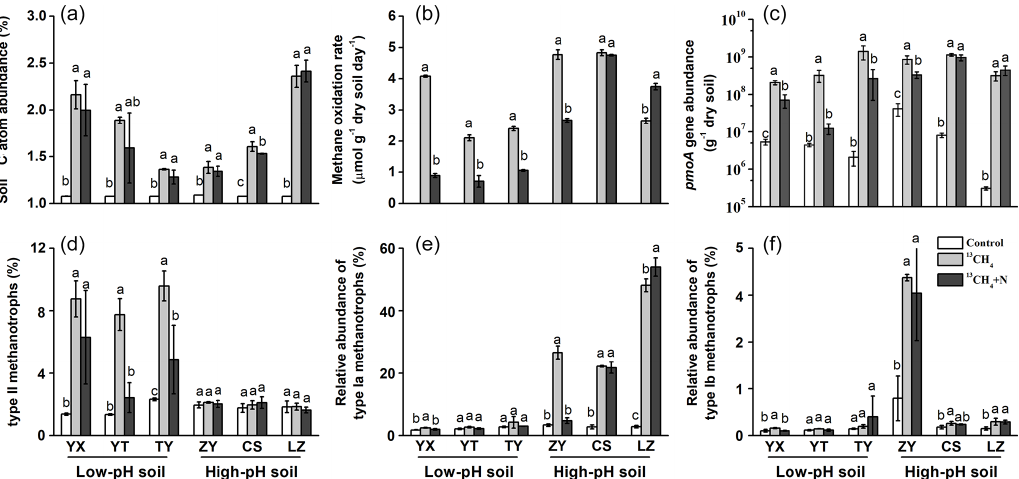
Figure 1. Changes in soil 13 C-atom abundances, methane oxidation rates, abundances and compositions of methanotrophs following soil microcosm incubation. (a) Soil 13 C-atom abundance was measured to assess methane assimilation in soil microcosms amended with 5% 13 CH 4 . (b) The soil methane oxidation rate was compared between soil microcosms incubated with or without NH 4 NO 3 fertilization. (c) The pmoA gene copy numbers of methanotrophs were estimated using real-time qPCR. Illumina sequencing targeting 16S rRNA genes was performed at the whole microbial community level, and the relative abundance of type II (d) , type Ia (e) and type Ib (f) methanotrophs was expressed as the percentage of affiliated gene reads relative to the total 16S rRNA gene reads in each microcosm. “Control” indicates soil under natural atmospheric conditions; “ 13 CH 4 ” and “ 13 CH 4 + N” refer to soil microcosms incubated with 5% v/v 13 CH 4 without and with extra NH 4 NO 3 fertilization, respectively. The designations below the x axis represent the soil sampling sites of rice paddy fields. All treatments were conducted in triplicate. The error bars represent the standard errors of the means. Different letters above the columns indicate a significant difference between different treatments in a given soil ( P < 0 . 05).